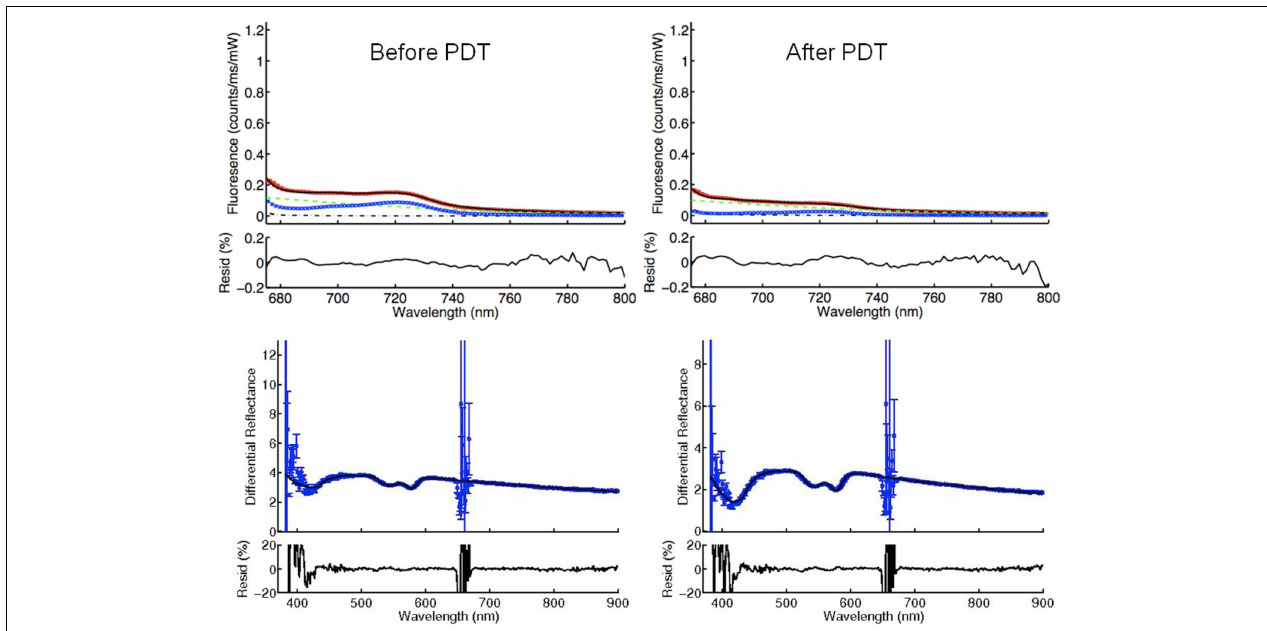
FIGURE 6 | FDPS (above) and DPS (below) spectra of lesion 12 before and after PDT. The blue lines in FDPS spectra are almost flat, indicating very small concentrations of mTHPC in the TC, both before and after PDT.